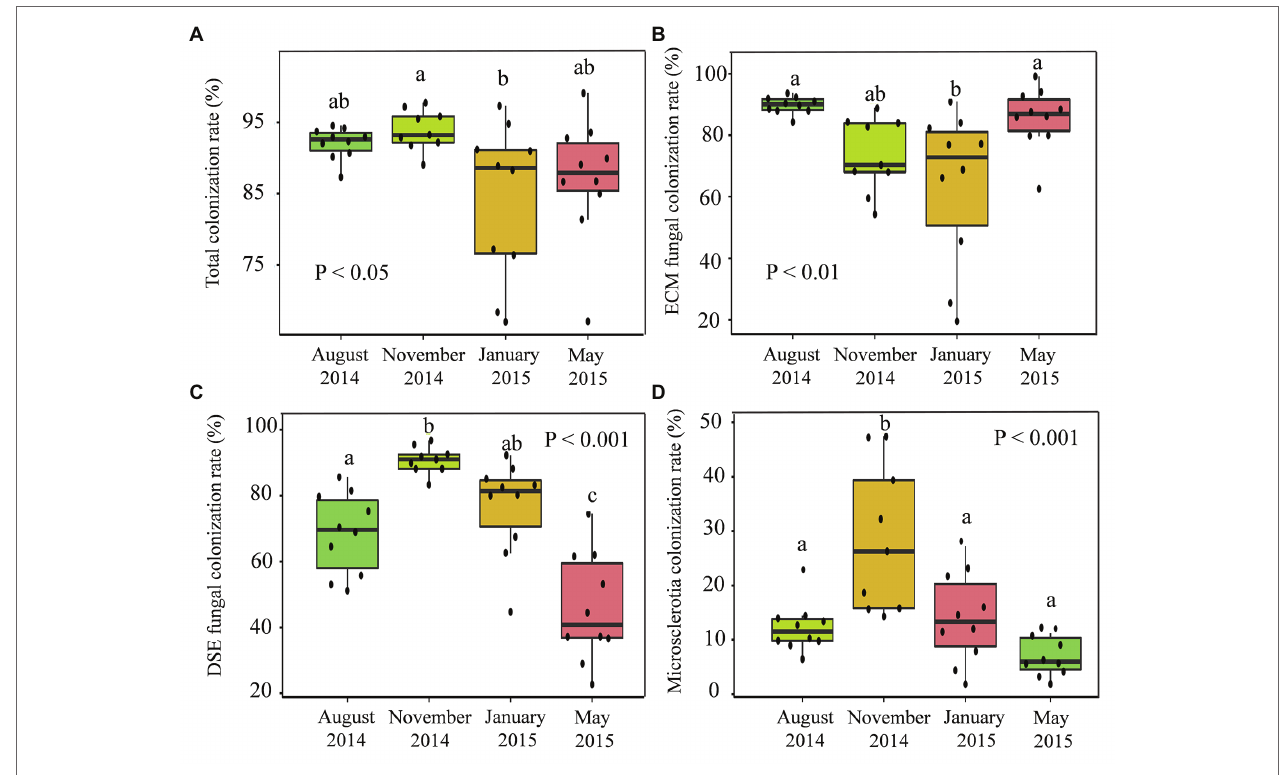
FIGURE 2 | Seasonal changes in the root fungal colonization rates in temperate Pinus tabuliformis forests located on the Qinling Mountains. (A) Total fungal colonization rate; (B) ECM fungal colonization rate; (C) DSE fungal colonization rate; (D) microsclerotia colonization rate. ∗ p < 0.05, ∗∗ p < 0.01, ∗∗∗ p <